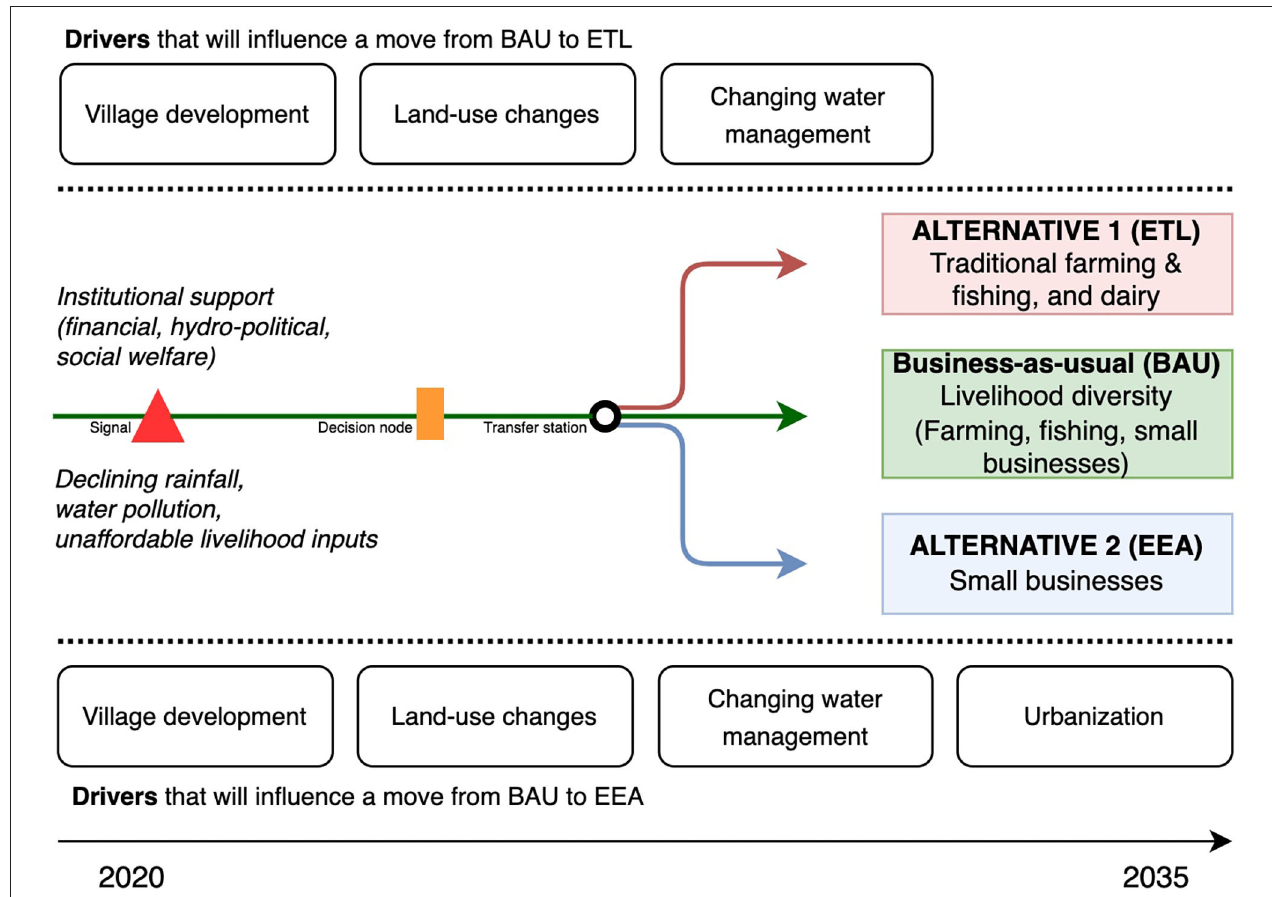
FIGURE 3 | Actors’ view on future livelihood